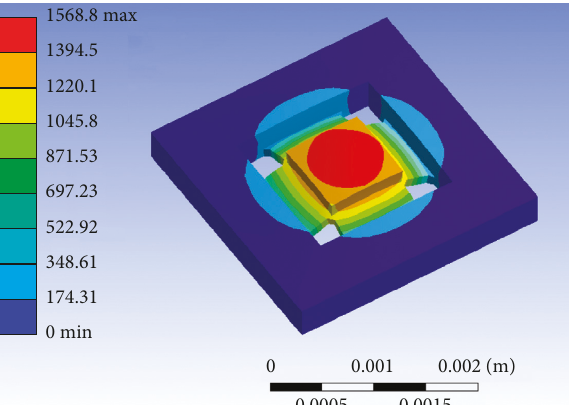
Figure 6: First mode simulation of the High-G MEMS accelerometer structure.